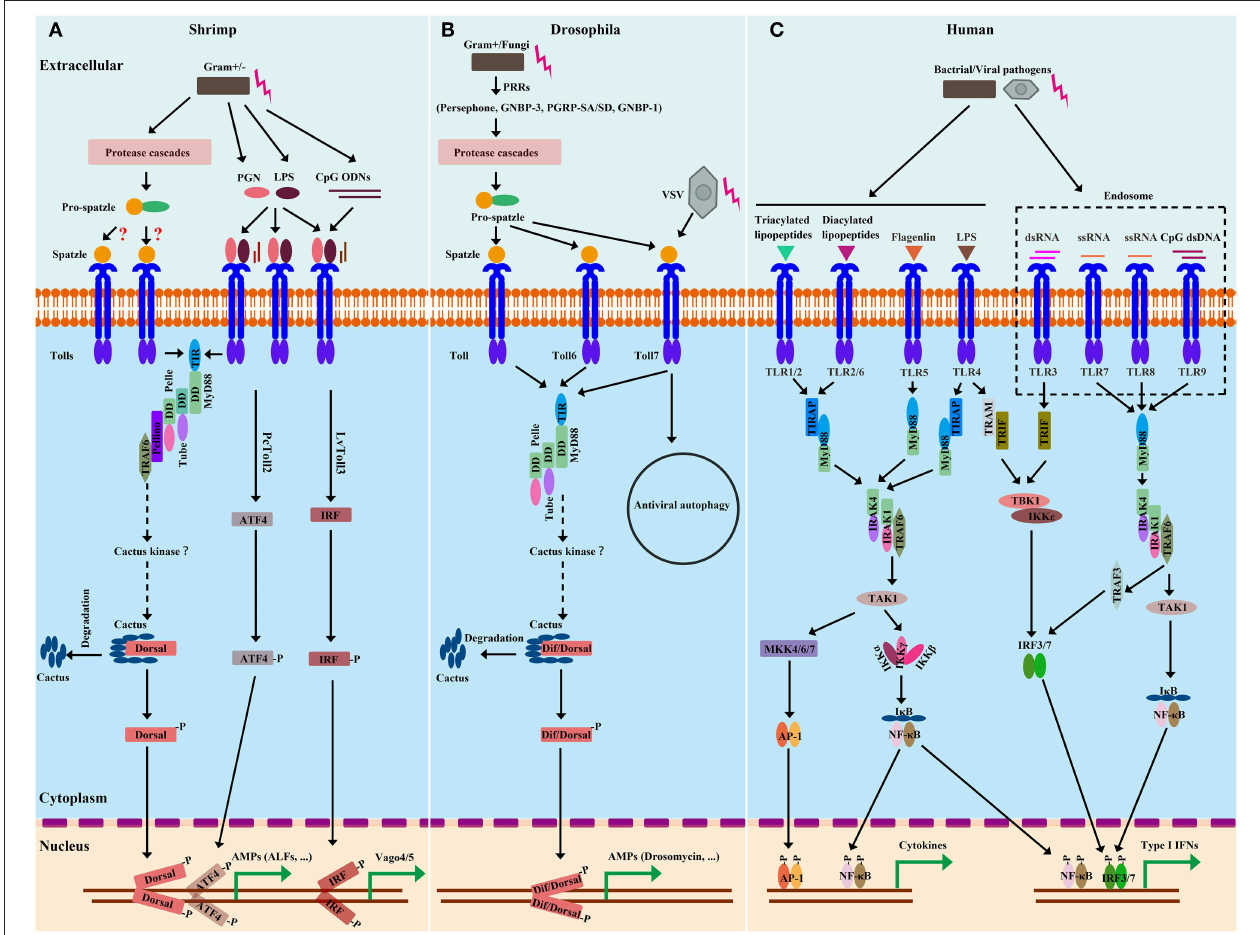
FIGURE 2 | Comparison of Toll and TLR pathways from shrimp (A) , Drosophila (B) , and Human (C) . Homologies between signaling components are depicted by similar shapes and colors. In shrimp, there are two extracellular-signaling routes leading to Toll pathway activation. Considering that many Spätzle (Spz) genes from shrimp have been identified and are able to induce Toll-Dorsal-controlled AMPs, the extracellular cleavage of Spz mediated by protease cascades could be similar to those of Drosophila . In the immune responses to microbial recognition, the protease cascades lead to the activation of Spz-processing enzymes (SPEs) to cleave full length Spz. Upon proteolytical processing, the Spz prodomain is cleaved, exposing the C-terminal Spz parts that are critical for binding of Toll. Spz binding to the Toll receptor initiates intracellular signaling. In contrast, shrimp Tolls are able to sense and directly bind to some conserved motifs, such as PGN, LPS, and ODN, from microbes, which are similar to those of Human . Upon binding to these motifs, shrimp Tolls are activated and initiate intracellular signaling. In the intracellular-signaling event, signaling cascades of shrimp Toll pathways broadly resemble those of Drosophila . After Toll activation, the adaptor MyD88 builds a signaling complex with Tube and Pelle. The MyD88-Tube-Pelle complex in turn recruits other regulators, such as Pellino and TRAF6, which leads to the phosphorylation and degradation of Cactus and thereby releases Dorsal (and/or Dif in Drosophila ) to translocate to the nucleus and activate transcription. In Human , there are MyD88-dependent and MyD88-independent signal-transduction events. The intracellular signaling of Human can lead to active NF- κ B, AP-1 and IFN regulatory factor 3/7 (IRF3/7) for their nuclear translocation and subsequent transcriptional activation of target genes. Of note, Toll3 from L. vannamei and Toll2 from P. clarkii have been shown to activate IRF and ATF4, respectively, leading to transcriptional synthesis of some antiviral effectors, such as Vago4/5 and